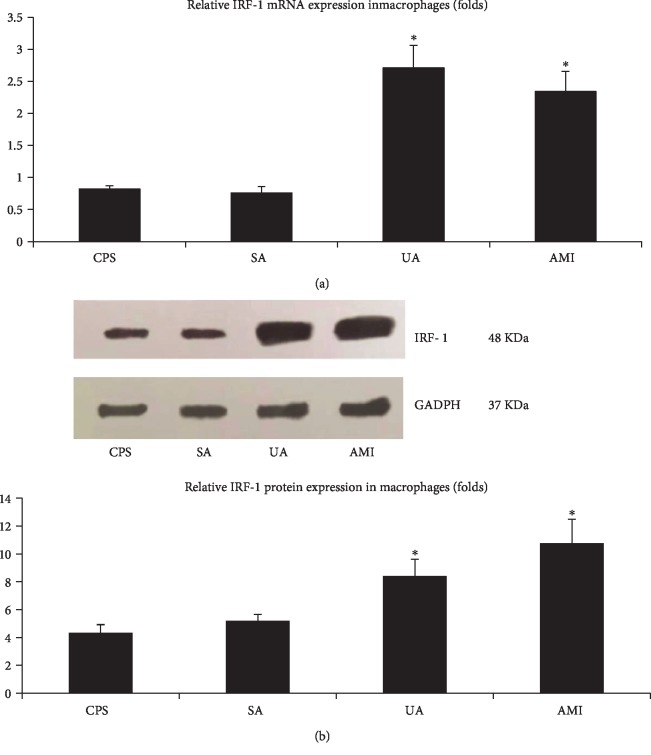
The relative mRNA and protein expression of IRF-1 in human PBMC-derived macrophages. (a) The relative IRF-1 mRNA expression was determined by real-time PCR. (b) The relative IRF-1 protein was determined by western blot. ∗ indicates vs CPS and SA group (∗p < 0.05). # indicates vs CPS group (#p > 0.05).